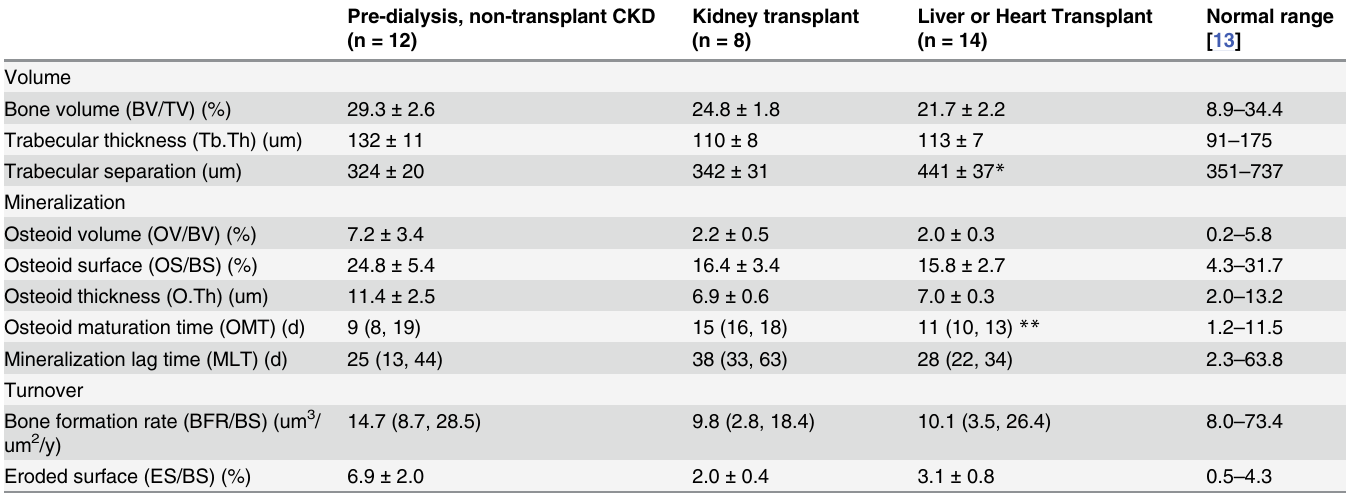
Table 2. Bone histomorphometric parameters in transplant and CKD